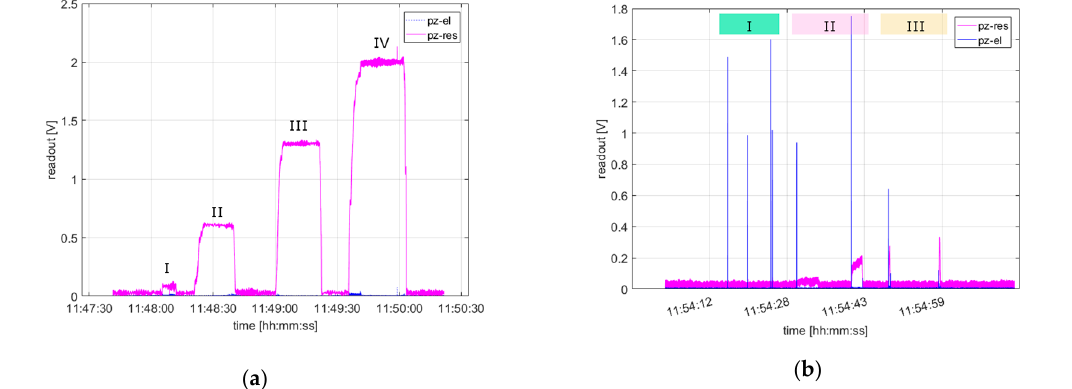
Figure 4. Results of the characterization of the joint system. ( a ) Static Response: 2 kg (case I), 5.3 kg (case II), 14.6 kg (case III) and 31.3 kg (case IV). Only the piezo-resistive element reacts to changes while the other produced very sparse spikes corresponding to placement and removal of the weights. ( b ) Dynamic Response: tapping with a finger (sec I), short pressure with 1 and 2 kg (sec II) and short pressure with a finger (sec